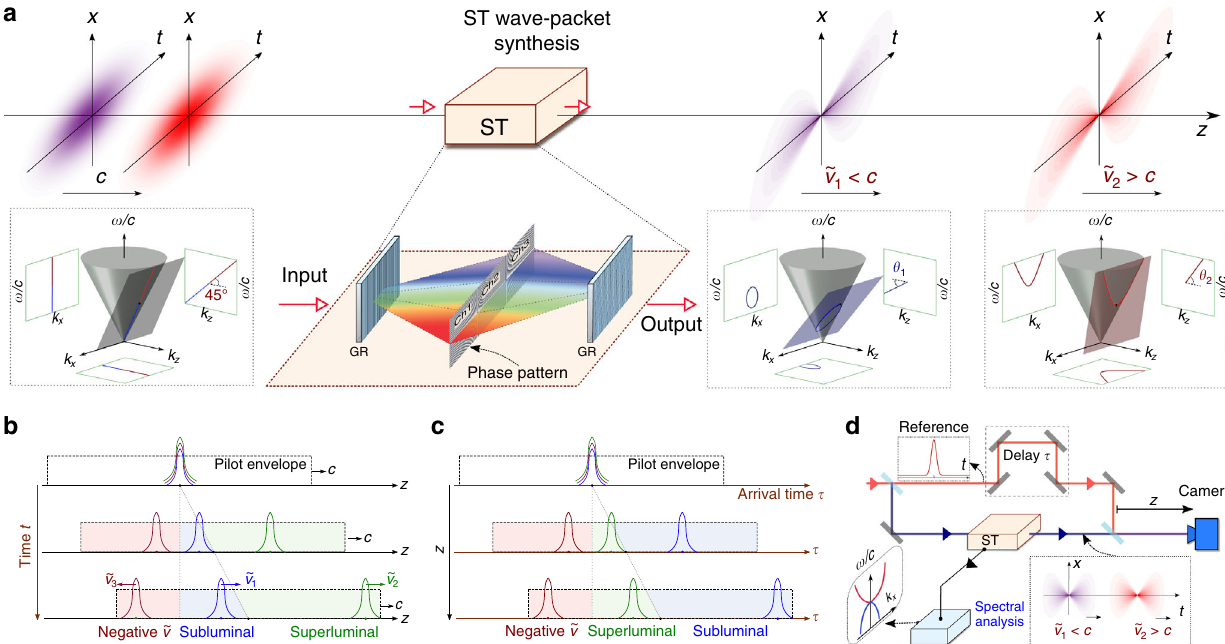
Fig. 1 Concept of a free-space optical delay line using ST wave packets. a Overall layout. Traditional pulses whose group velocities are equal ( e v ¼ c ) are converted into ST wave packets each assigned a different group velocity (subluminal e v 1 and superluminal e v 2 ), so that they separate in time upon free propagation. The spatio-temporal spectrum of the traditional pulses and the ST wave packets are depicted on the surface of the light-cone k 2 x þ k 2 z ¼ ð ω c Þ 2 , and their spectral projections are also shown (straight line for a plane-wave pulse, an ellipse for a subluminal ST wave packet, and a hyperbola for a superluminal ST wave packet). Here e v ¼ c tan θ , where θ is the spectral tilt angle with respect to the k z -axis. Inset shows the structure of the ST wave packet synthesizer for multiple spectral channels (Ch1, Ch2, and Ch3); GR: Diffraction grating. b Dynamics of ST wave packets under the pilot envelope. The locations of subluminal, superluminal, and negative- e v ST wave packets are shown along the propagation axis z at different instances in time. c The arrival times τ of ST wave packets are shown at different detector locations along z . d Schematic of the optical setup for synthesizing and characterizing ST wave